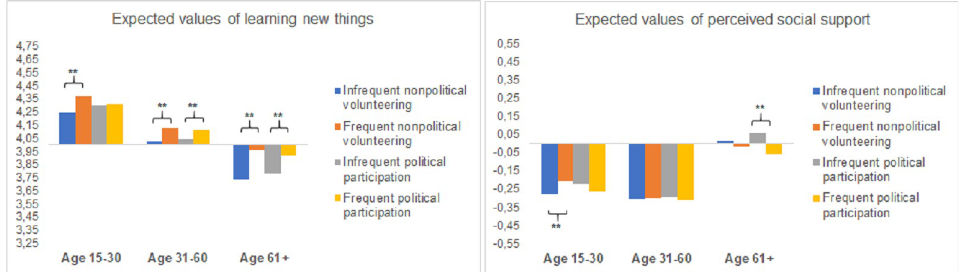
Fig 2. a. Effects of voluntary participation on learning new things are moderated by age. b. Effects of voluntary participation on perceived social support are moderated by age.